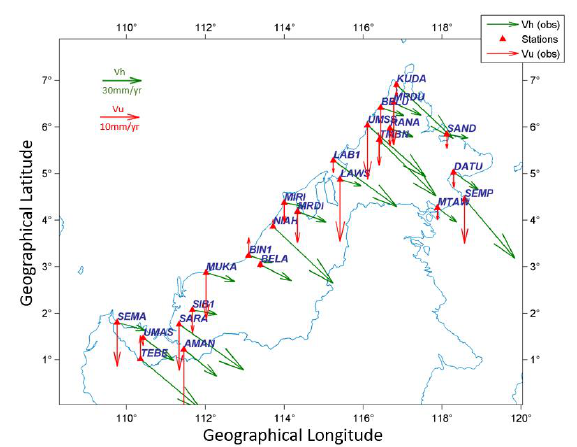
Figure 10. Site velocities in Sabah and Sarawak as estimated from twenty-three (23) MyRTKnet sites in 2012 To validate the site velocities, the observed velocities were compared with the computed velocities as in Table 2. Ten (10) MyRTKnet sites in Sabah and Sarawak from year 2012 were selected for this discussion. It can be observed that the residual between observed and computed velocities were found at average -1mm/yr and 0.4mm/yr for horizontal and vertical components respectively.